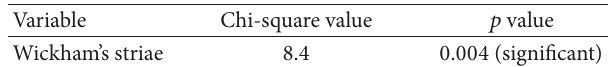
Figure 7: Mast cells distribution between study group. Table 1: Chi-square